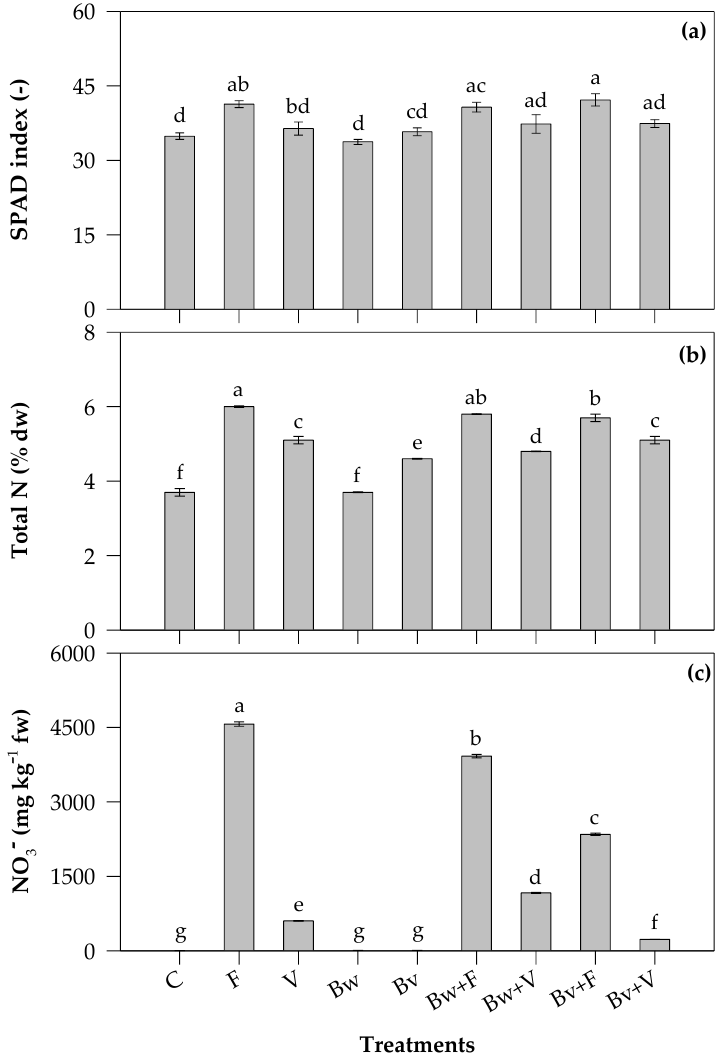
Figure 1. SPAD index ( a ), total nitrogen (total N, % dw) ( b ) and nitrate (NO 3 − , mg kg − 1 fw) ( c ) contents of Swiss chard leaves. C, control; F, ammonium nitrate; V, vermicompost; Bw, biochar from wood chips; Bv, biochar from vine prunings; Bw+F and Bv+F, biochars respectively mixed with ammonium nitrate; Bw+V and Bv+V, biochars respectively mixed with vermicompost. Values are means (n = 4) ± s.e. Different letters above histograms indicate significant differences among treatments ( p ≤ 0.05; Tukey’s